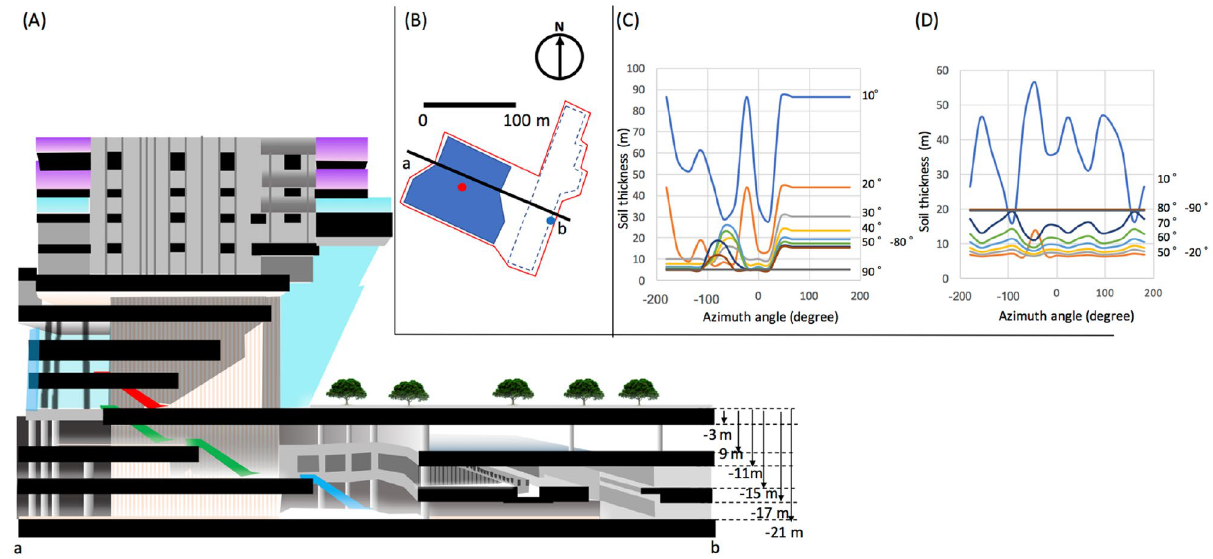
Figure 6. Schematic view of the Toranomon Hills Station Tower (THST) complex ( A ). The top view of the complex is shown in ( B ). The a-b line indicates the intersectional line of the cross-sectional view shown in ( A ). The red lines indicate the underground space of the complex. The red and blue filled circles respectively indicate the position of "A" and "B" used for the discussion in the main text. The corresponding soil/concrete thickness distributions are respectively shown in ( C , D ). The copyright of this image is owned by